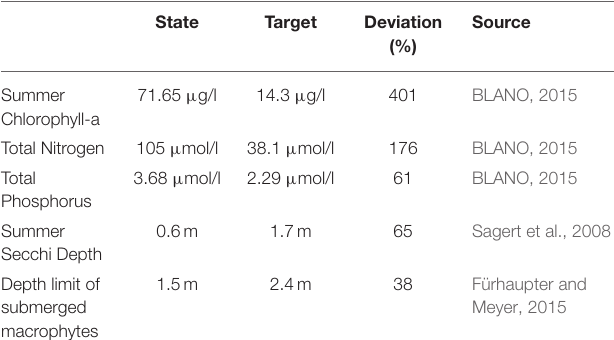
TABLE 1 | Present state and GES-thresholds for central water quality indicators in Small